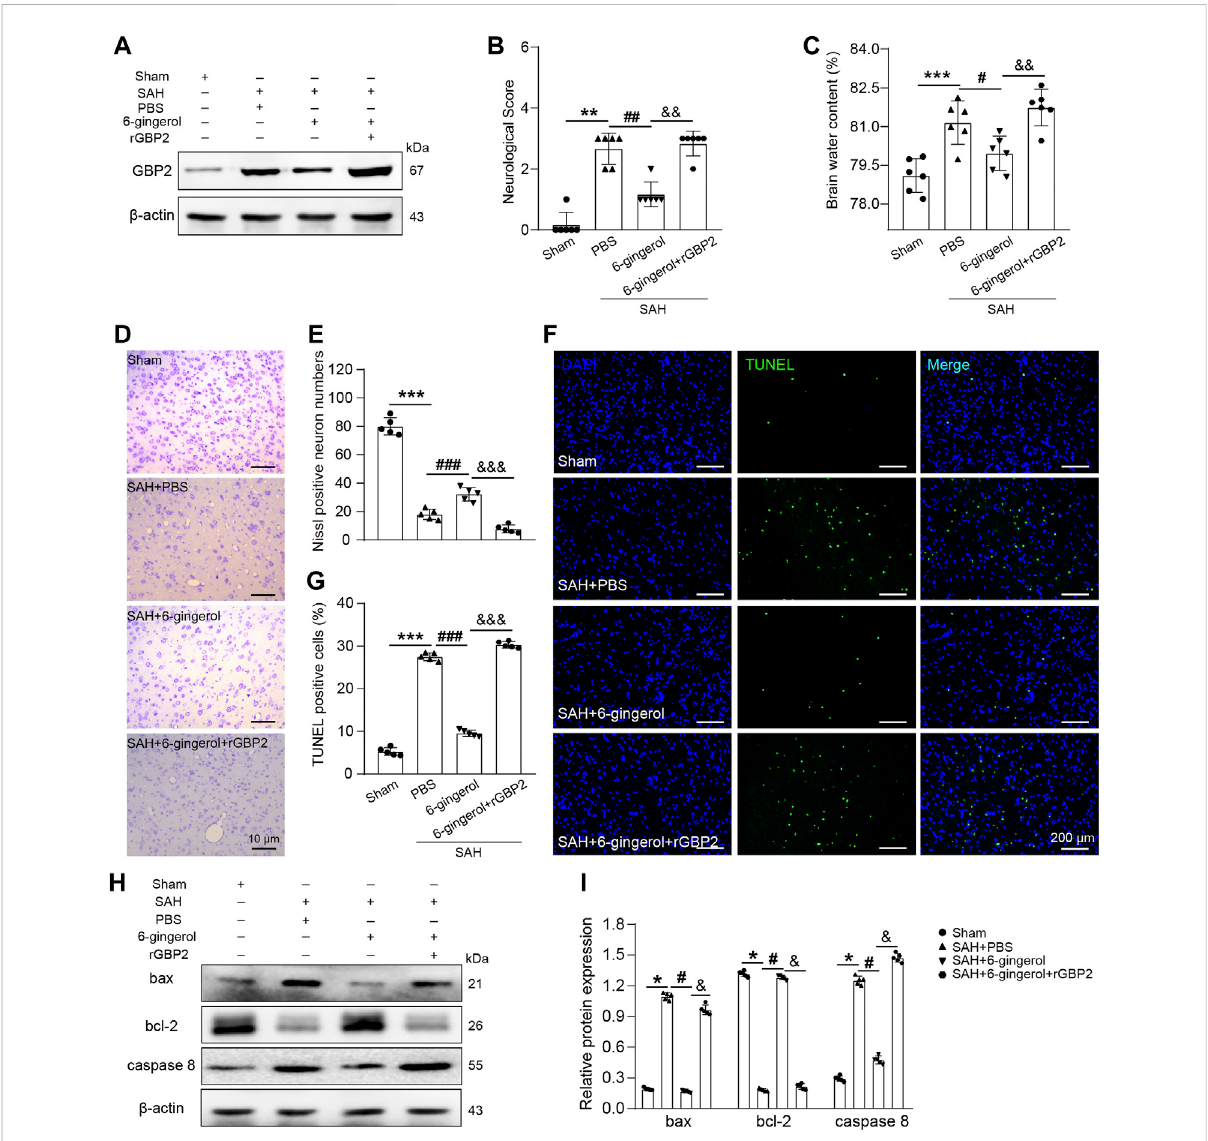
FIGURE 5 6-gingerol inhibits GBP2-mediated neuronal apoptosis in SAH rats. (A) GBP2 protein expression was detected by western blotting in rats of the sham, SAH + PBS, SAH + 6-gingerol and SAH + 6-gingerol + rGBP2 groups. (B) Quantitative analysis of neurological scores, n = 6, Mann-Whitney U test was used. (C) Quantitative analysis of brain water content, n = 6. One-way ANOVA was used followed by Tukey ’ s post hoc test. (D) Representative images of Nissl staining. Scale bar = 10 μ m. (E) Quantitative analysis of Nissl-positive neuron numbers, n = 5. One-way ANOVA was used followed by Tukey ’ s post hoc test. (F) Representative images of TUNEL staining. Scale bar = 200 μ m. (G) Quantitative analysis of TUNEL- positivecells,n=5.One-wayANOVAwasusedfollowedbyTukey ’ sposthoctest. (H)